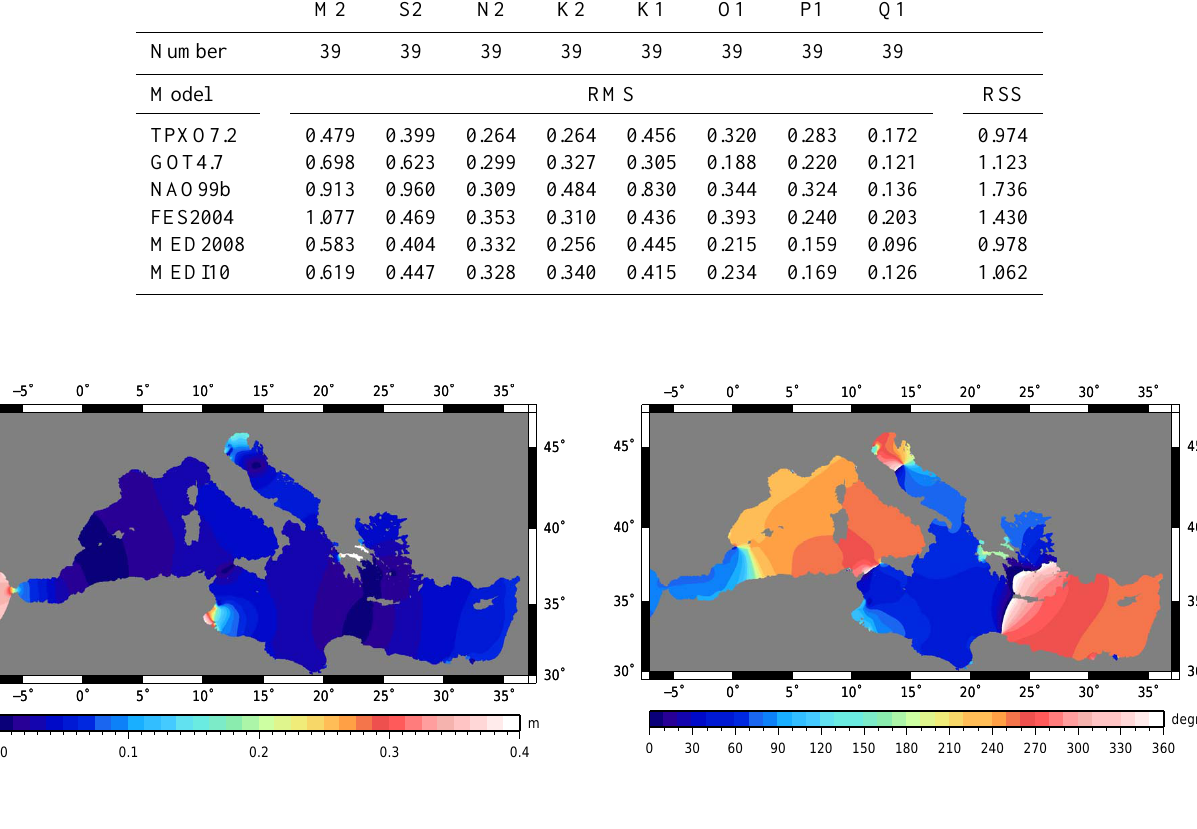
Fig. 6. Amplitude of the S2 constituent. Fig. 7. Phase of the S2 constituent (degrees relative to